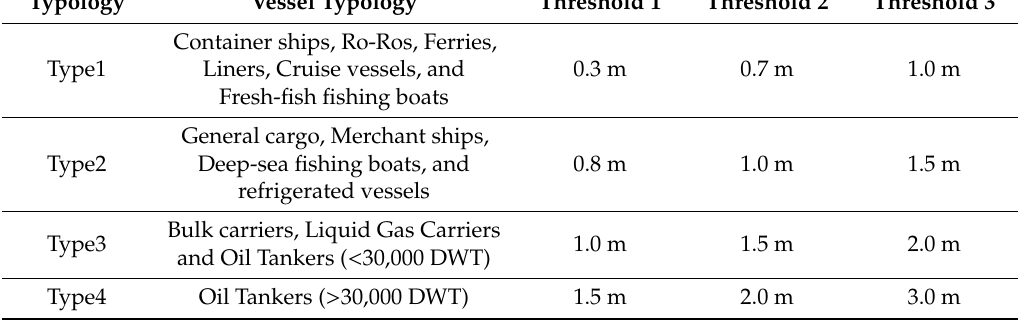
Table 3. Threshold assignment to each AOI typology based on the limit operating conditions at quays and jetties from ROM3.1-99 [49]. Typology